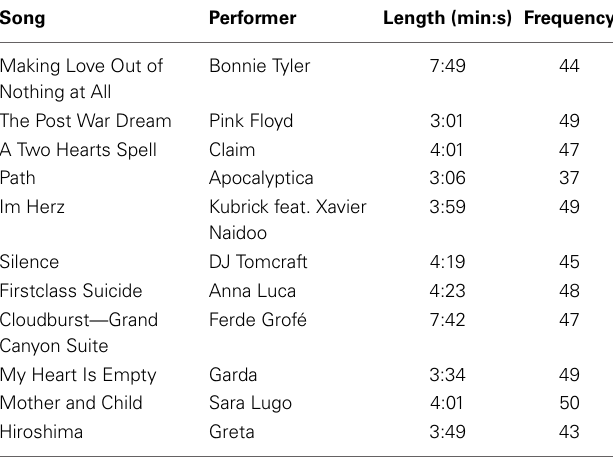
Table 1 | Songs used in the